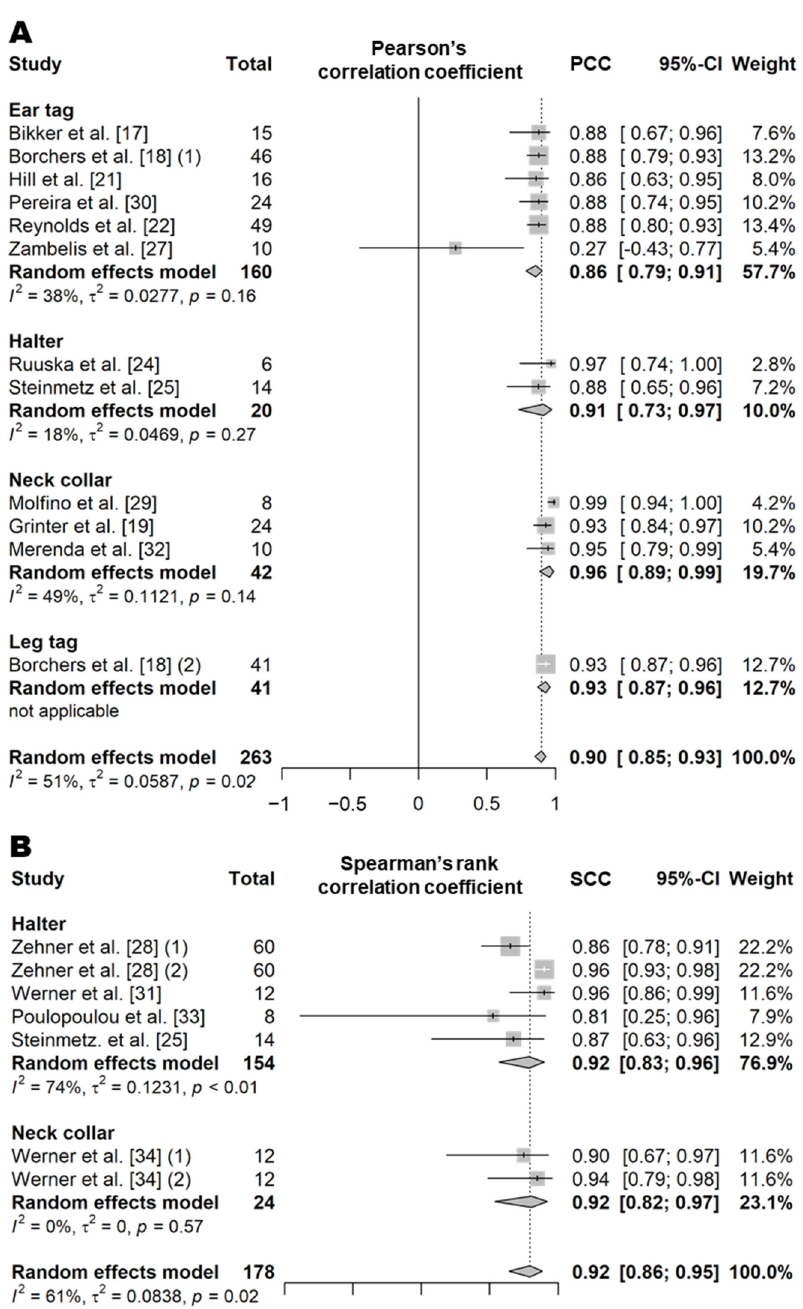
Figure 1. Forest plots of the correlation coefficient of eating time between wearable sensors and visual observation. ( A , B ) show Pearson’s correlation coefficient and Spearman’s correlation coefficient, respectively. Numbers in parentheses indicate individual studies applying different evaluation conditions within the same article. ‘Total’ means the sample size of each study and ‘Weight’ means the weight for the mean based on the sample size.